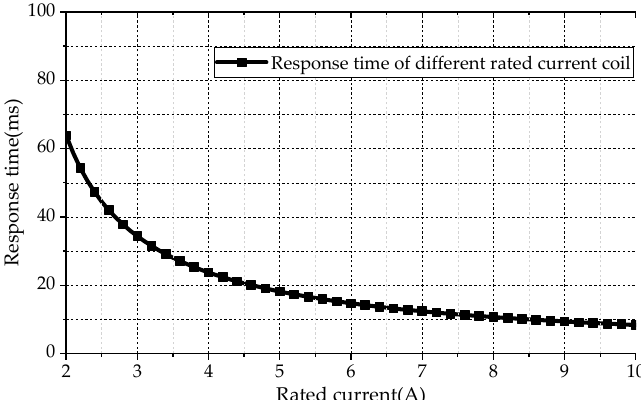
Figure 12. Theoretical response time of the rated current at end position of the working stroke.